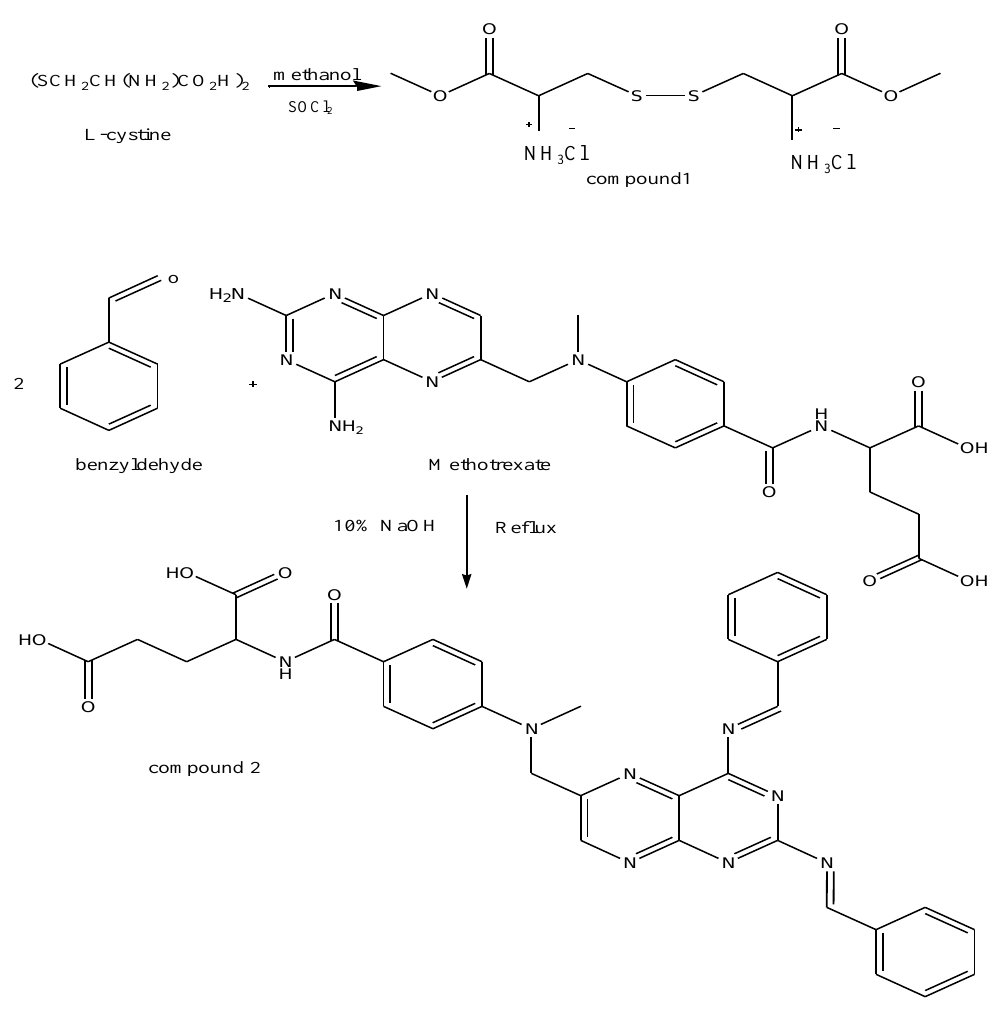
(table2) .Infrared spectroscopy (table3) and 1 H- NMR done